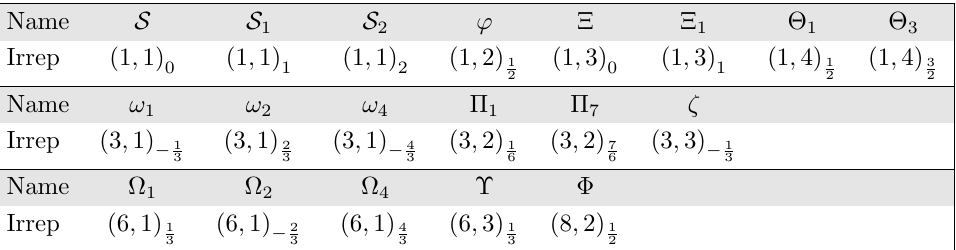
Table 1 . New scalar bosons contributing to the dimension-six SMEFT at tree level.